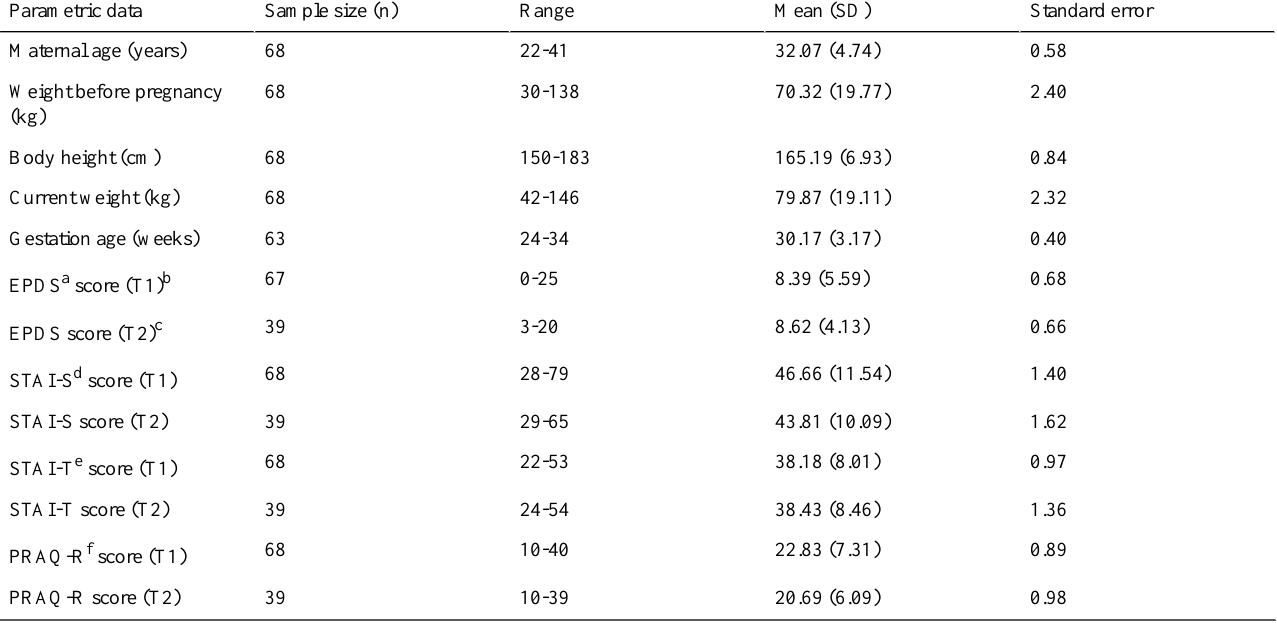
Table 5. Analysis of the parametric sample